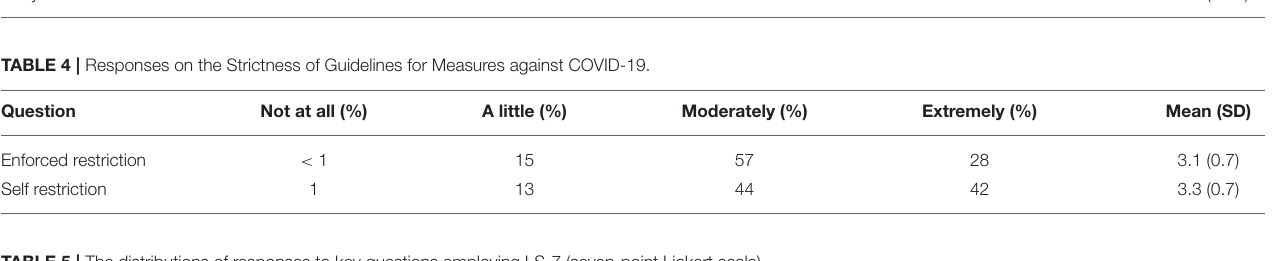
TABLE 5 | The distributions of responses to key questions employing LS-7 (seven-point Lickert scale). Question